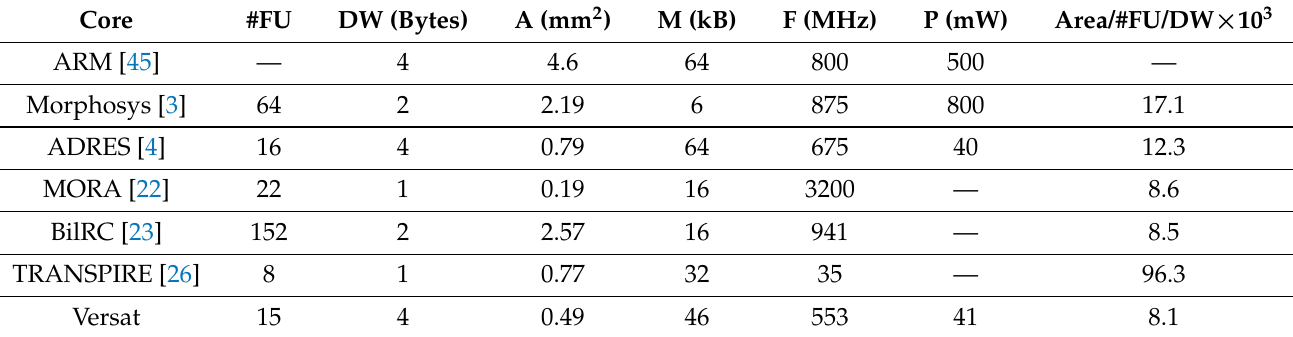
Table 5. IC results scaled to 40